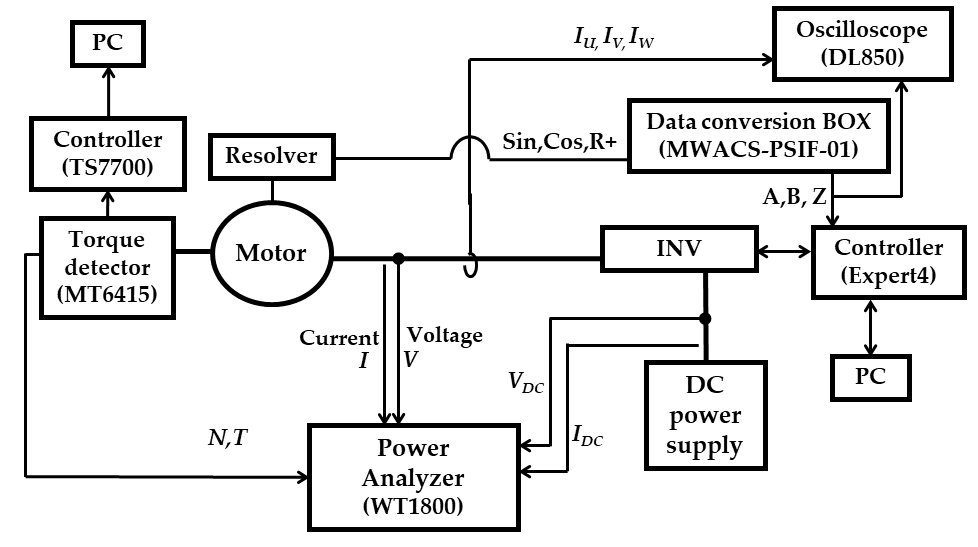
Figure 20. Measurement system configuration.